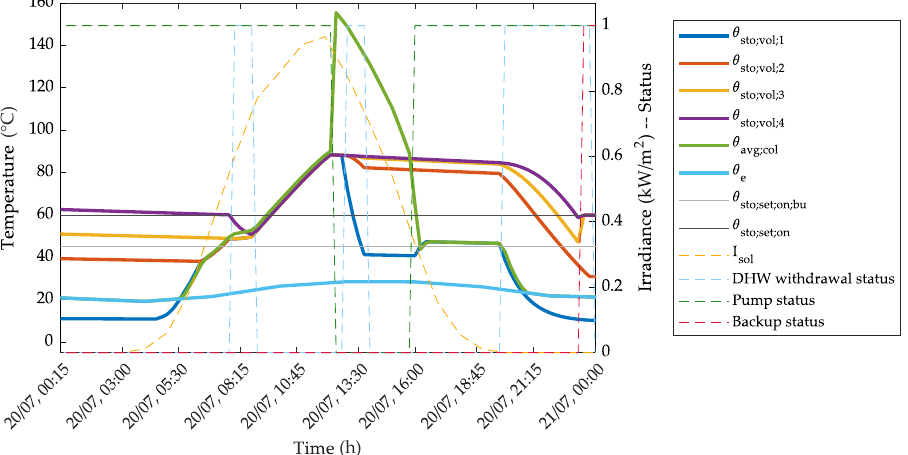
Figure 9. The effect of a smaller storage tank on system temperatures in a hot summer day. Time step: 15